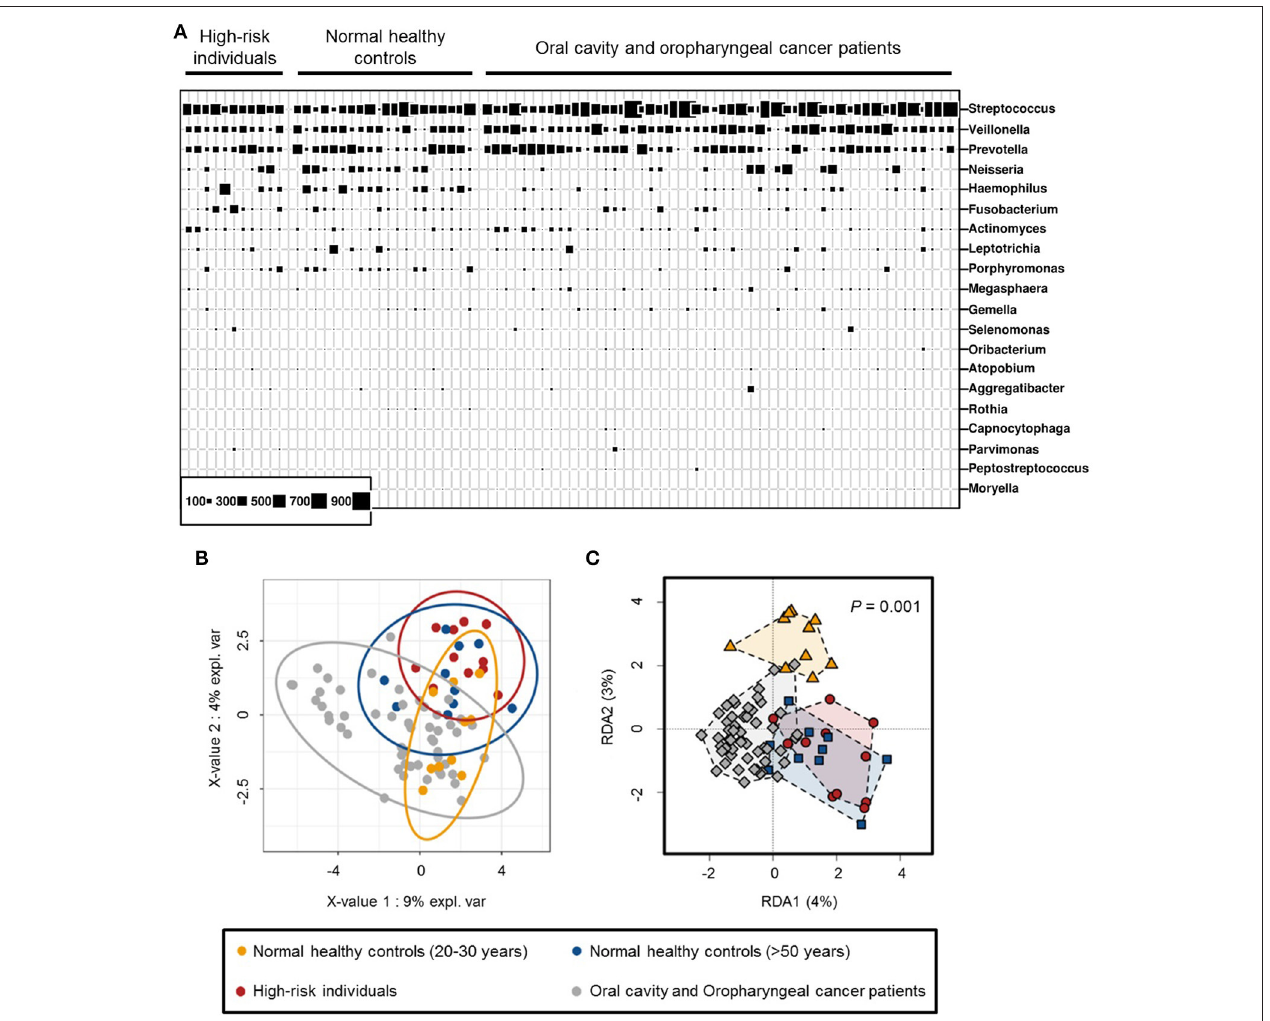
FIGURE 2 | (A) Bubble plot of 20 most abundant bacterial genera detected in oral rinse samples of normal healthy controls (between 20 and 30 years of age, n = 10 and above 50 years of age, n = 10), high-risk individuals ( n = 11) and oral cavity and oropharyngeal cancer patients ( n = 52). (B) Partial least squares regression-discriminant analysis (PLS-DA) and (C) redundancy analysis of microbial communities (genus-level) in oral rinse samples, based on OTU frequencies within respective